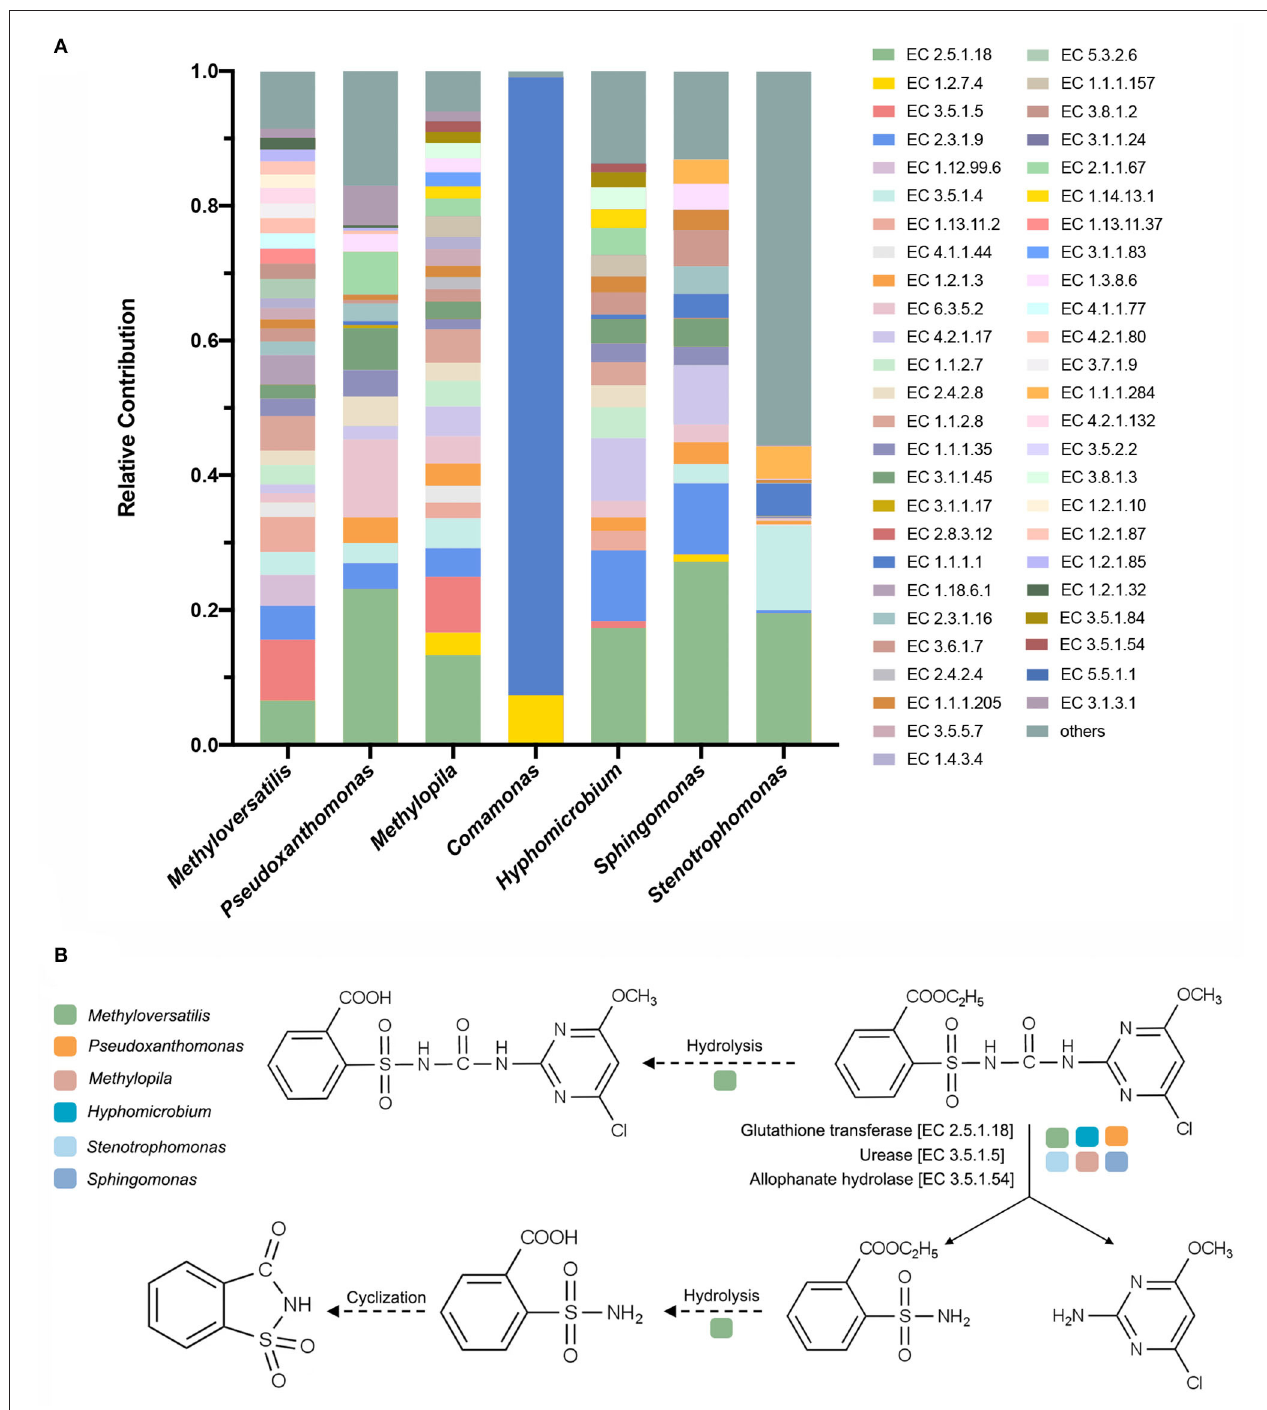
FIGURE 6 | (A) Analysis of the functional contribution of seven possible degrading genera at the enzyme level; (B) proposed degradation pathway of chlorimuron-ethyl by MC-L1. Solid lines indicate the enzymes and pathways present in the MC-L1; dashed lines indicate the inferred pathways.